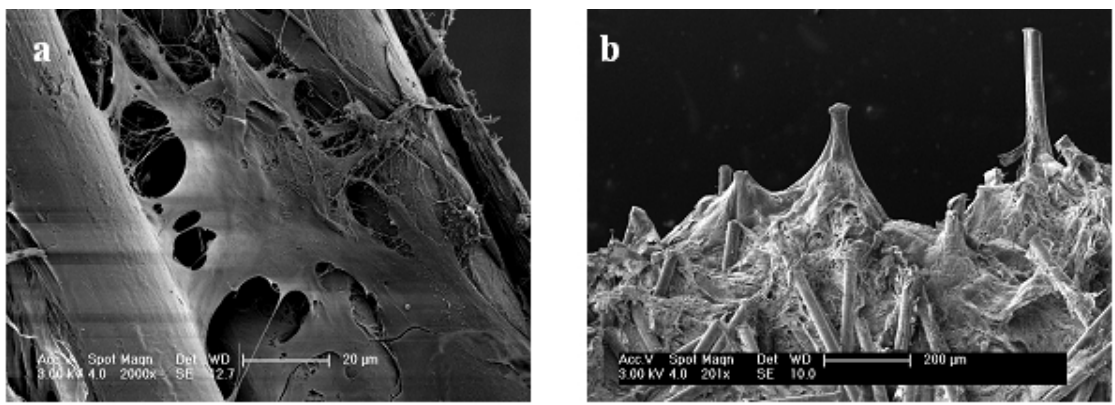
Figure 7. Scanning electron microscopy images of cell seeded samples (1 mm fiber length and 15 sec flocking time). ( a ) Single cell that stretches between two fibers; ( b ) Scaffold after 28 days of cultivation. All spaces between the fibers are filled with cells and newly deposited ECM.